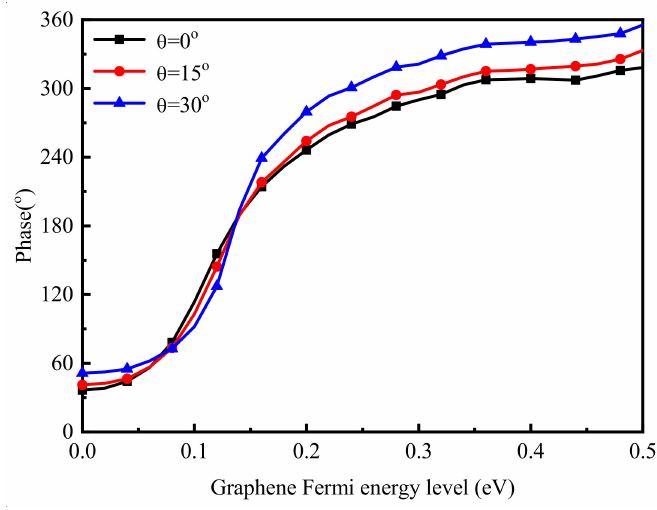
Figure 4. Changing trends of reflection phases at different incident angles with various Fermi levels of